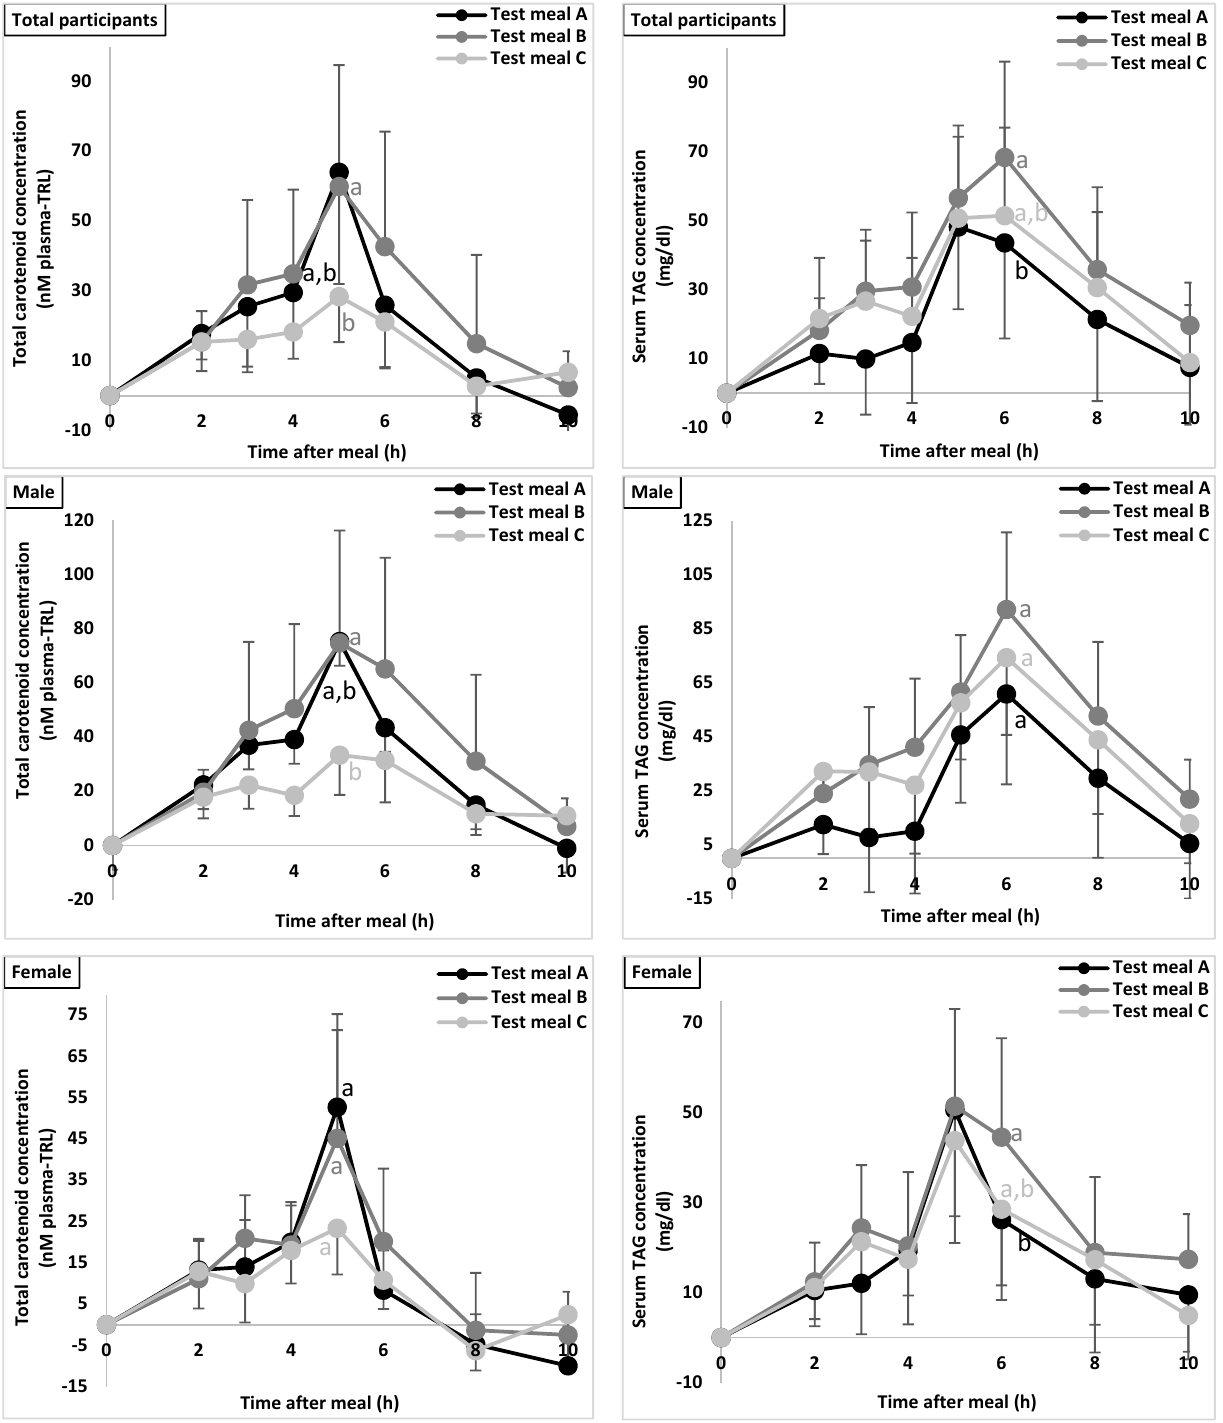
Figure 3. Effect of different protein types on the postprandial serum TAG concentrations and plasma TAG-rich lipoprotein (TRL) concentration of carotenoids. Changes in plasma TRL-carotenoids (left panel) and serum TAGs (right panel) were assessed over a 10 h period after the intake of a test meal without (control, test meal A) or including one of the two investigated proteins, namely whey protein isolate (WPI, test meal B) or soy protein isolate (SPI, test meal C). Plasma TRL-carotenoid concentrations (nM) and serum TAG concentrations (mg/dl) are expressed as mean values (total participants n = 24, male/female n = 12) with their standard errors. AUC were compared for statistically significant differences as outlined in the “Statistical Analyses” section. Solid lines not sharing the same alphabetical letter (a,b) are considered significantly different.